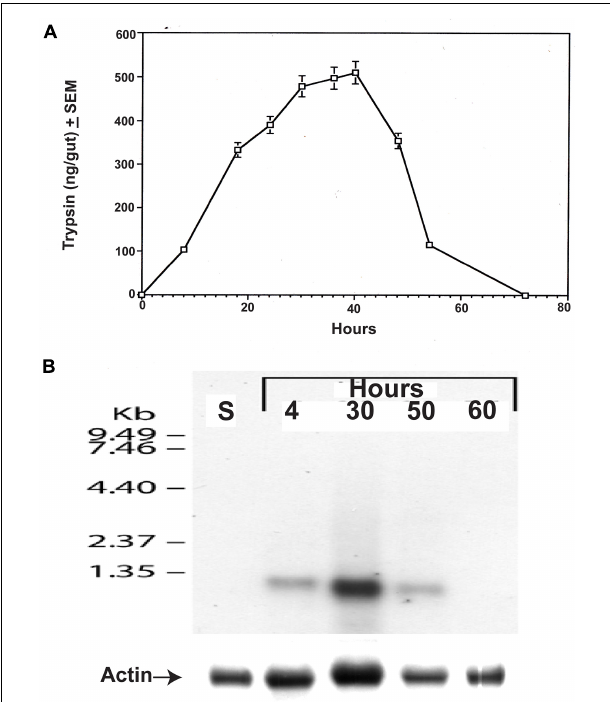
FIGURE 7 | Culex quinquefasciatus late trypsin amounts and trypsin transcript in the gut at different times after the blood meal. (A) Trypsin amounts (ng/gut) were followed in the gut after the blood meal (Borovsky and Schlein, 1988). The results are expressed as means of three determinations + SEM. (B) Northern blot analysis of the late trypsin transcript in the gut epithelial cells at different times after the blood meal and in sugar-fed female gut epithelial cells (S). Actin was run as a control to show equal transfer and the analysis was repeated two times showing similar results.